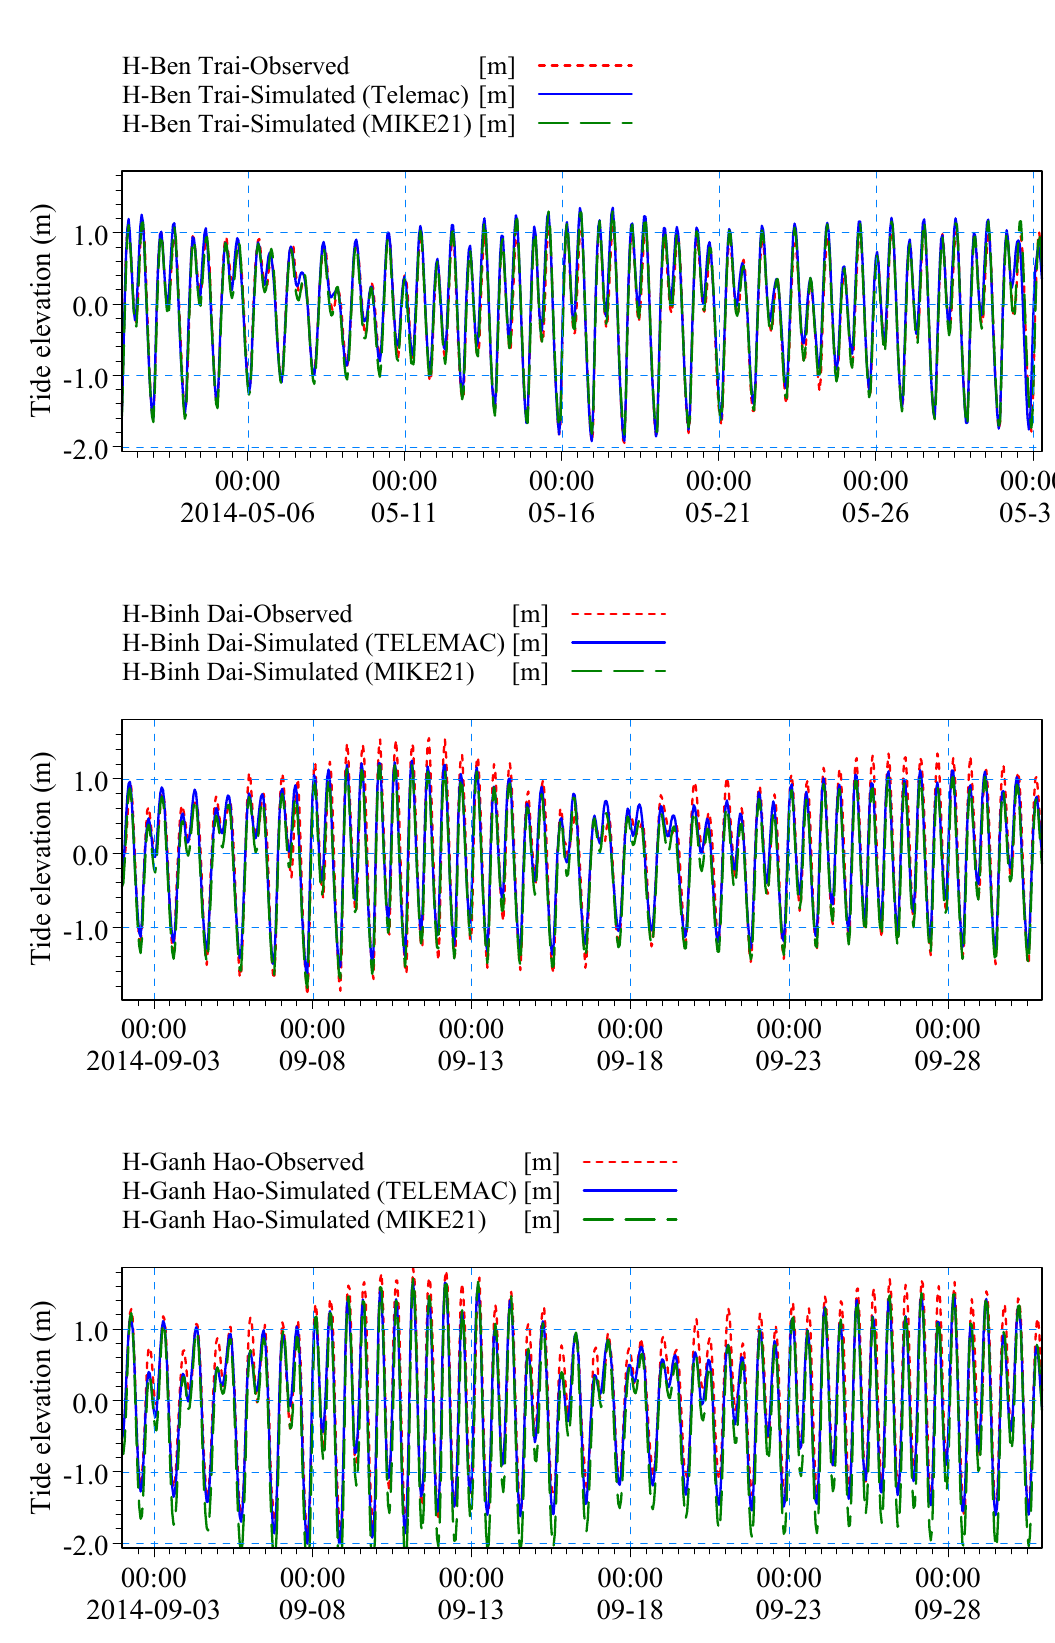
Figure 4. Water level calibration for Ben Trai, Binh Dai, and GanhHao (national stations).